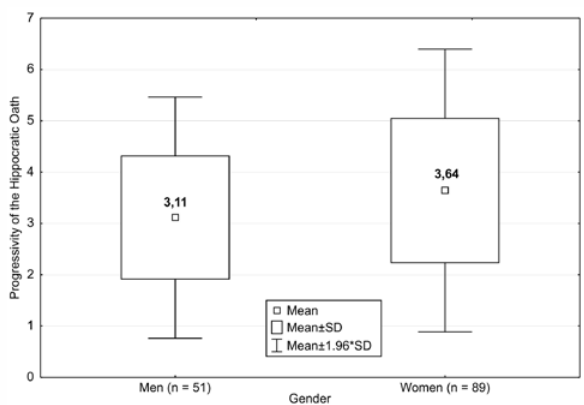
Figure 3: Factor of progressivity for the Hippocratic